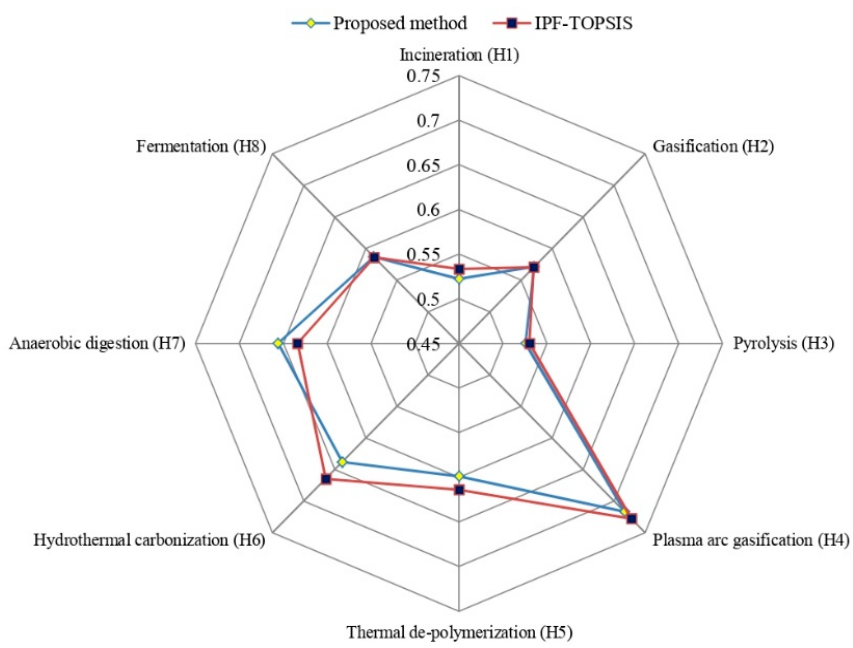
Figure 5. Comparison of utility degree/closeness index of each for MSW